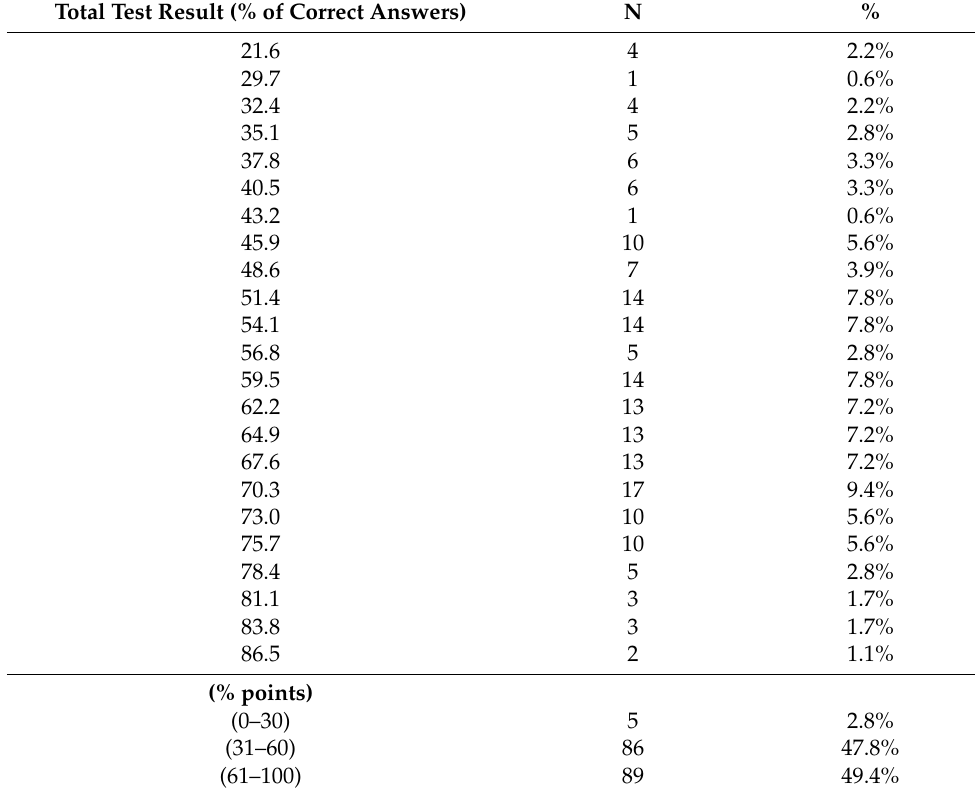
Table 3. Summary test